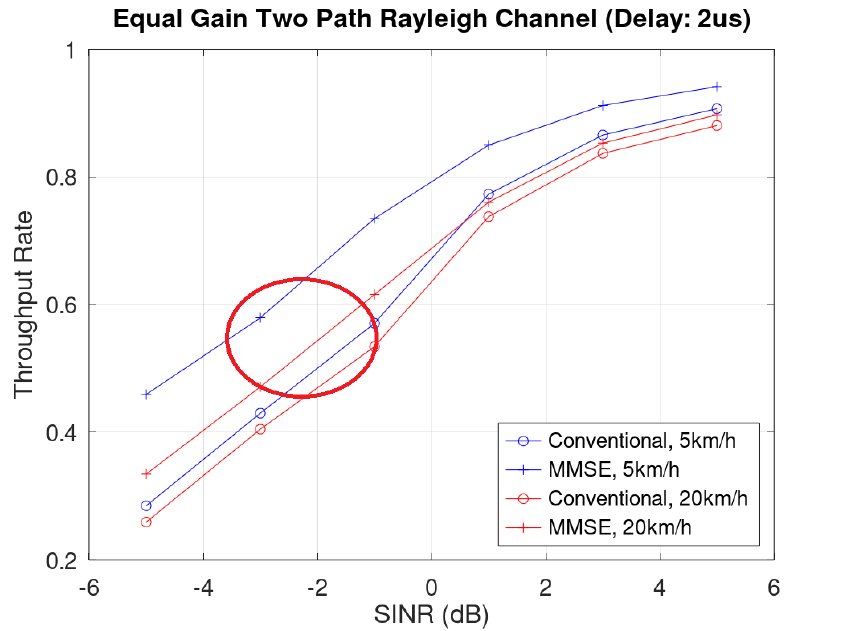
Figure 6. Throughput rate in an equal-gain two-paths Rayleigh fading channel with 2 us